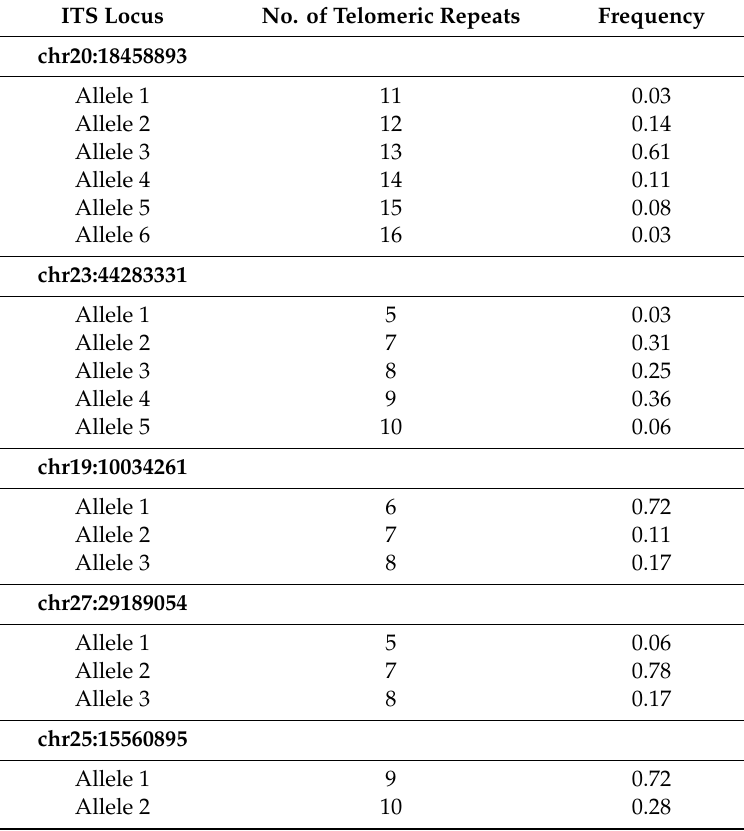
Table 3. Variable number of tandem repeats at 11 ITS loci in 18